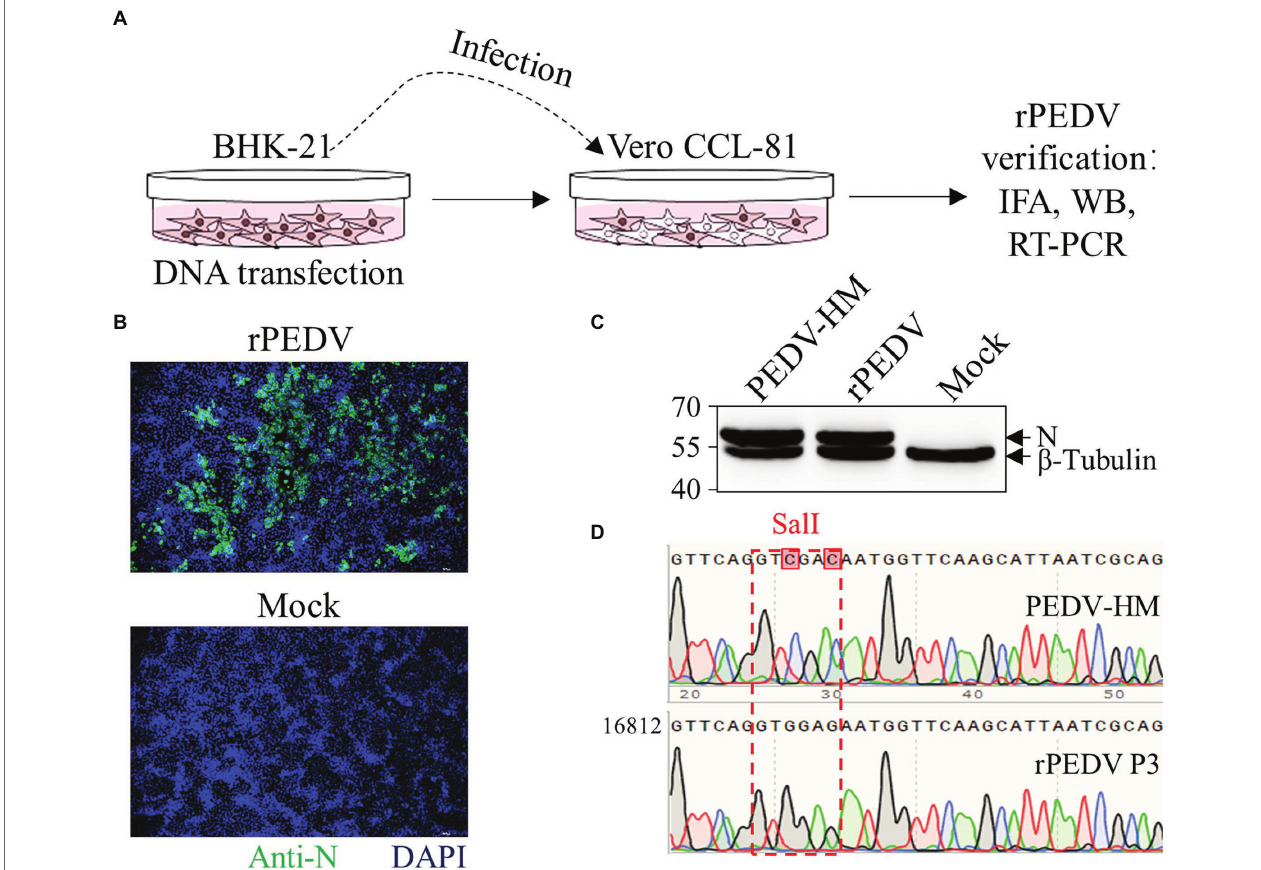
FIGURE 3 | Recovery and verification of recombinant PEDV. (A) A schematic diagram of recombinant PEDV recovery and verification. In brief, BHK-21 cells at 70% confluence in a six-well plate were transfected with 2 μ g PEDV infectious cDNA clone and 0.5 μ g pCAGGS-PEDV-N using Lipofectamine 3000 transfection reagent according to the manufacturer’s instructions. At 48 h post-transfection (hpt), the culture supernatant harvested from BHK-21 cells was transferred to the confluent Vero CCL-81 cell monolayer and replenished with DMEM containing 10 μ g/ml trypsin. The cell monolayer was checked daily for CPE, and the expression of N protein was evaluated by IFA and western blot analysis (WB). (B) N protein detection by IFA. At 4 days post-infection (dpi), Vero CCL-81 cells were fixed and stained with a mAb against N protein followed by incubation with the Alexa Fluor 488-conjugated goat anti-mouse IgG(H + L). The fluorescent pictures were taken under an IX73 epifluorescence microscope. (C) N protein detection by WB. Vero CCL-81 cells were infected with PEDV HM P12 or rPEDV at an MOI of 0.1, and mock-infected Vero CCL-81 cells were used as control. At 2 dpi, cell lysates harvested with IP lysis buffer were used for (WB) with a mAb against N protein, and β -tubulin was detected as a loading control. (D) Verification of recombinant PEDV by checking the genetic marker. The regions from nt 16,768 to 19,263 within PEDV HM P12 and rPEDV were amplified and verified by DNA sequencing. As expected, the SalI site in rPEDV was disrupted by two nucleotide substitutions at nt 16,820 and